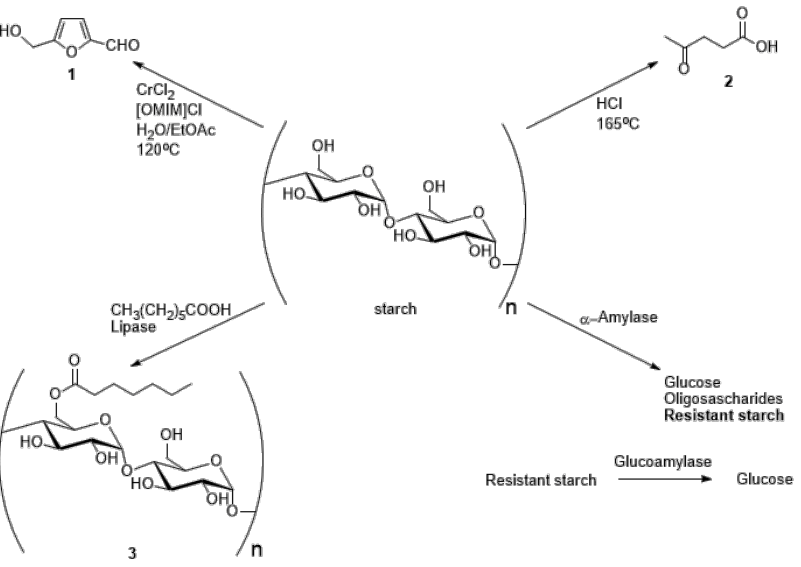
Figure 2. Chemical and biochemical transformations of the potato starch studied in this paper.